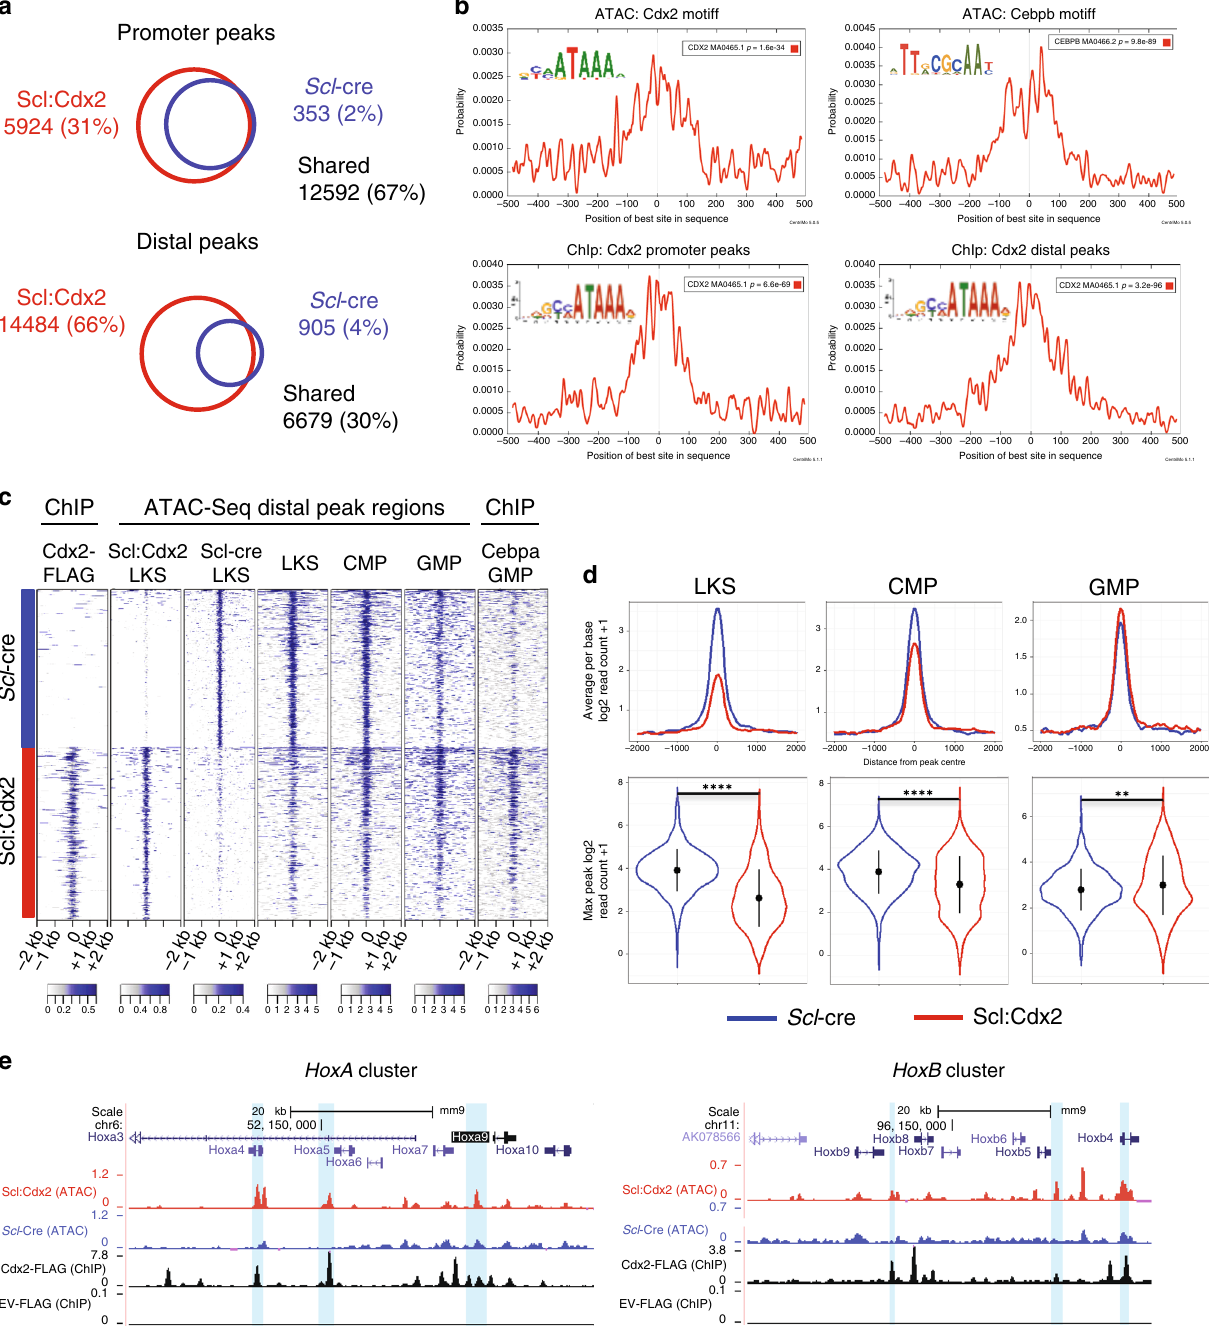
Fig. 6 Cdx2 modi fi es chromatin access in regions with critical differentiation factors. a Number of ATAC-Seq peaks found in Scl -Cre and Scl:Cdx2 BM LKS + cells. b Centrally enriched motifs in peaks speci fi c for Scl:Cdx2 BM samples by ATAC-Seq and Cdx2-FLAG BM samples by ChIP-Seq (as labeled) determined by MEME Suite. c Heatmaps of the top 1000 gained peaks at distal elements (peak centres + / − 2000 base pairs) that overlap between Cdx2- Flag BM samples by ChIP-Seq and Scl:Cdx2 or Scl -Cre BM samples by ATAC-Seq, ordered by signal intensity. LKS, CMP, GMP ATAC-Seq read coverage 43 and Cebp α GMP ChIP-Seq read coverage included at the same locations. Color scale shows Log2 + 1 normalized read counts. d Average peak height (top) and max peak height distribution (bottom) of distal ATAC-Seq peaks relating to ( c ). e UCSC browser tracks (mm9 murine genome) of Scl:Cdx2 and Scl - Cre ATAC-Seq peaks, and Cdx2-FLAG and Empty vector (EV) ChIP-Seq peaks in HoxA and HoxB clusters. Peaks called by MACS2. Light blue vertical bars highlight Scl:Cdx2 gained peaks positioned with a Cdx2 ChIP-Seq peak and Cdx2 motif. Statistical analyses for ( d ) performed using